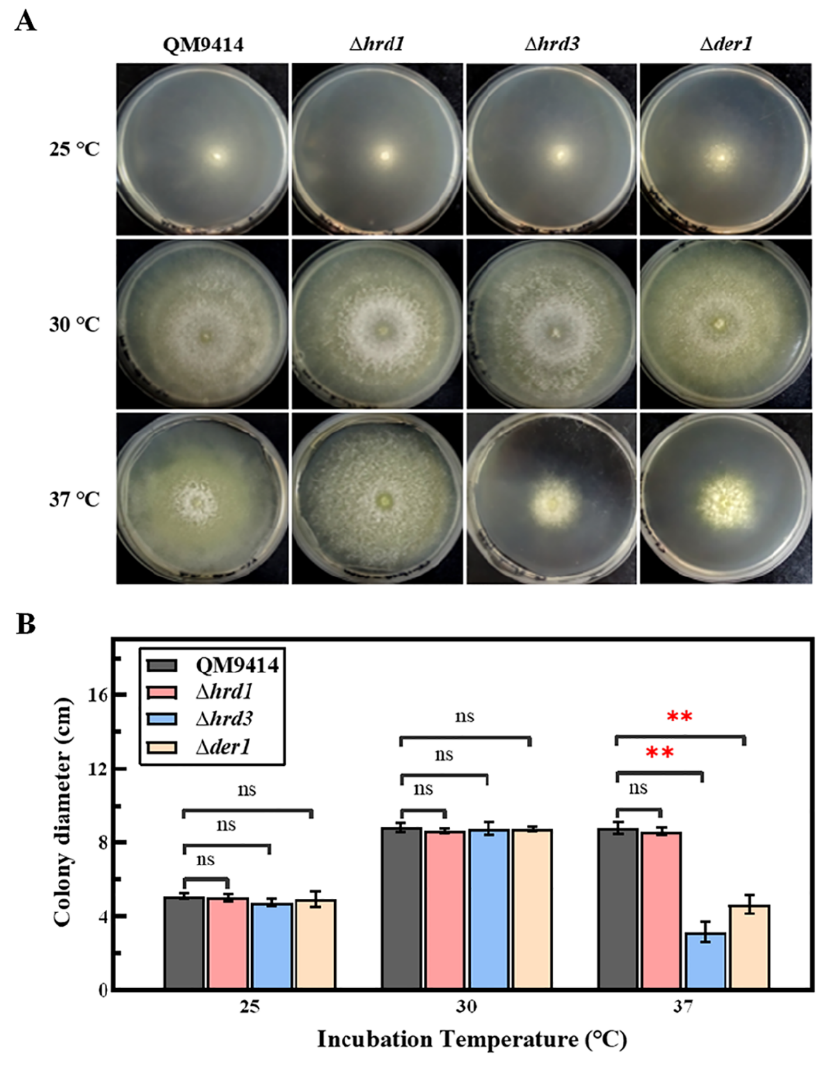
Figure 3. Thermal tolerance of the ERAD-deficient mutants at different culture temperatures. ( A ) The parental strain QM9414 and the ERAD-deficient mutants were grown on MM containing glucose as the carbon source and incubated under the given temperature conditions (25, 30, 37 °C). Growth was monitored for 3 days. ( B ) The colony diameters of QM9414 and the ERAD-deficient mutants were measured at different culture temperatures. Values represent the mean of three repeated measurements taken from at least three parallel experiments. The error bars refer to the standard deviations. The difference between the parental strain and the knockout strains was shown by analysis of ANOVA followed by Tukey’s test. ** p < 0.01. ns, not